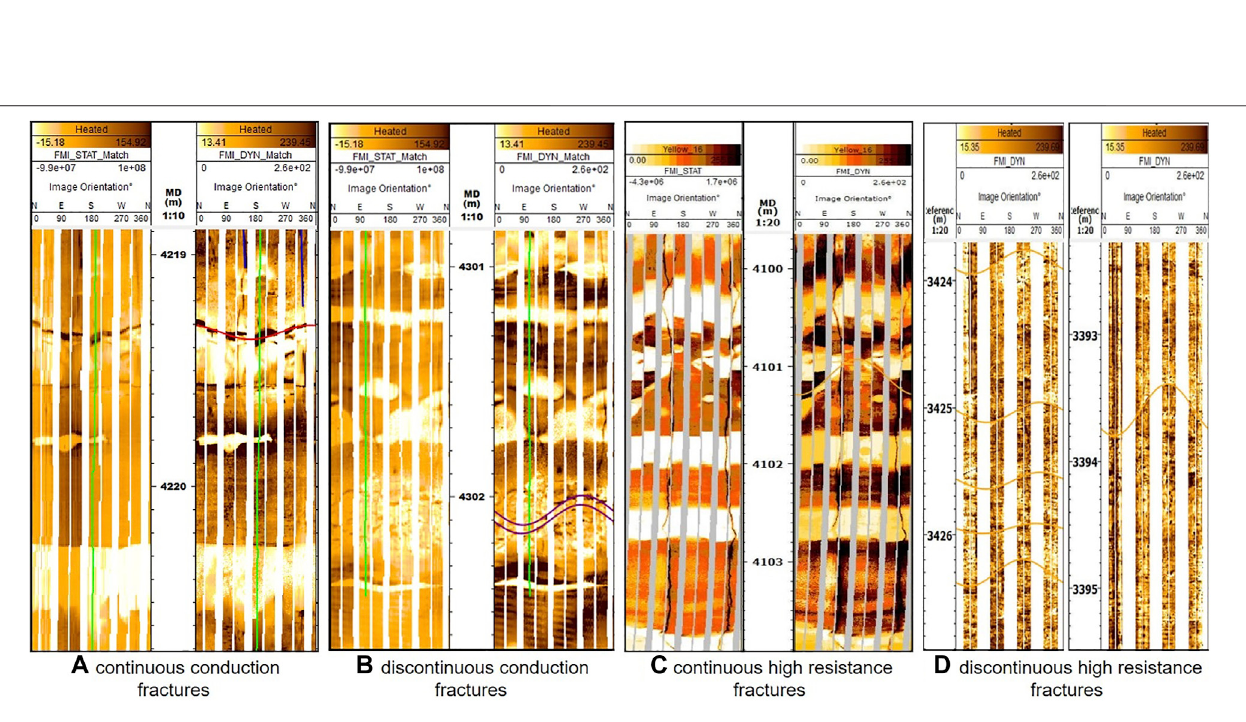
Frontiers in Earth Science |